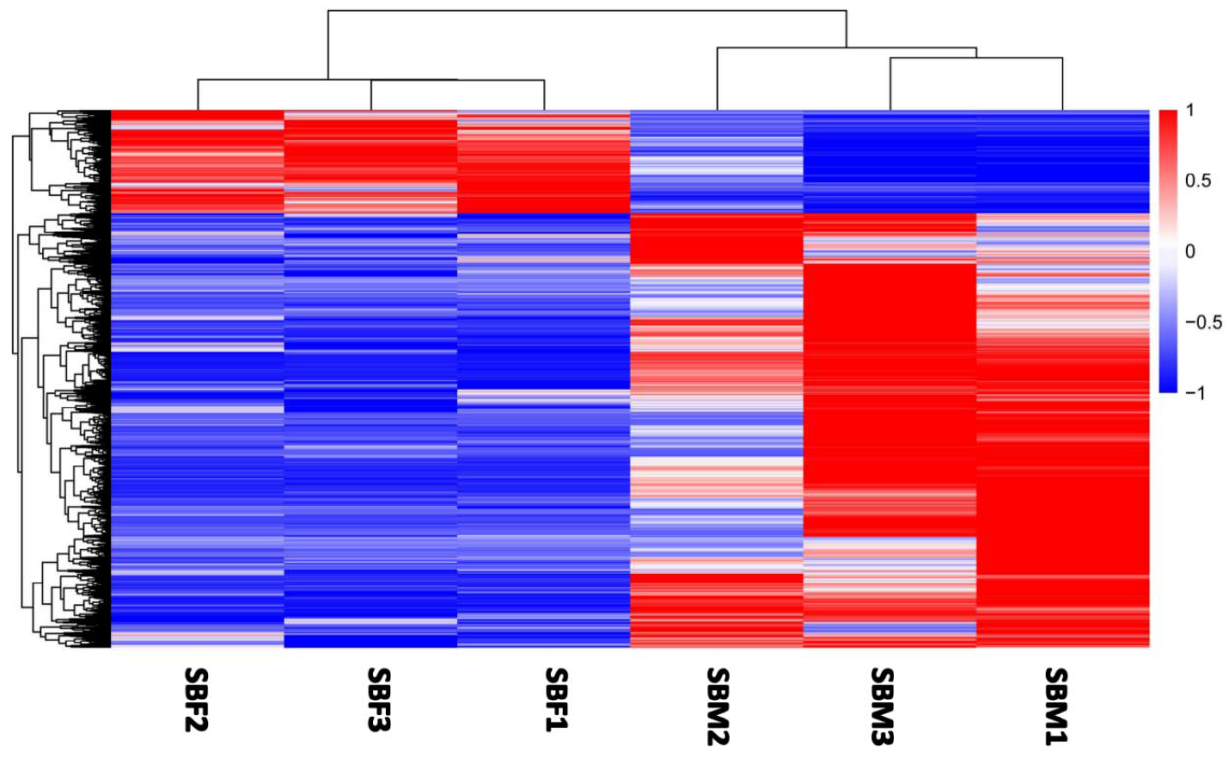
Figure 2. The expression trend of DEGs across all of the samples. The red color represents higher expression, and the blue color indicates lower expression.